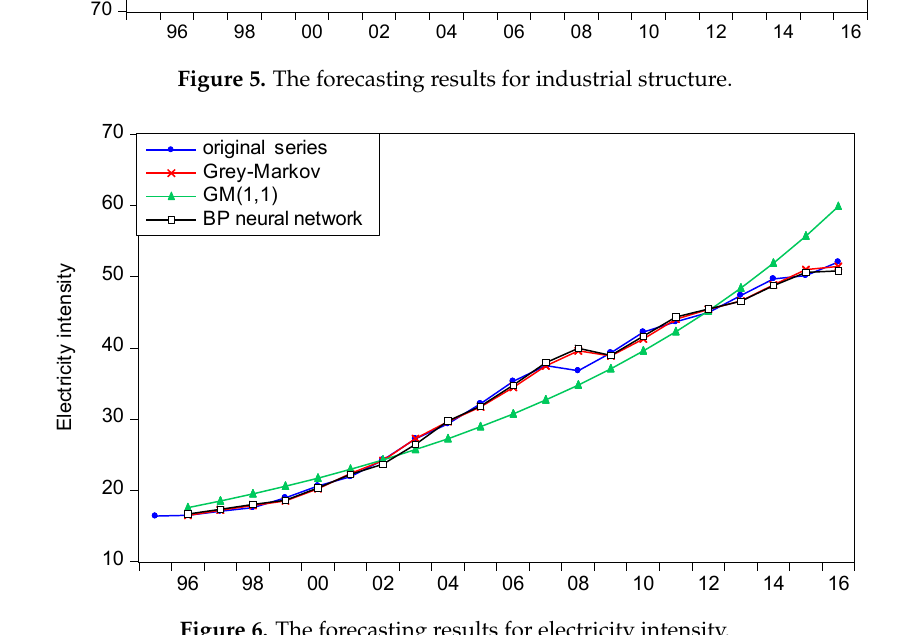
Figure 6. The forecasting results for electricity intensity. Energies 2018 , 11 , x FOR PEER REVIEW